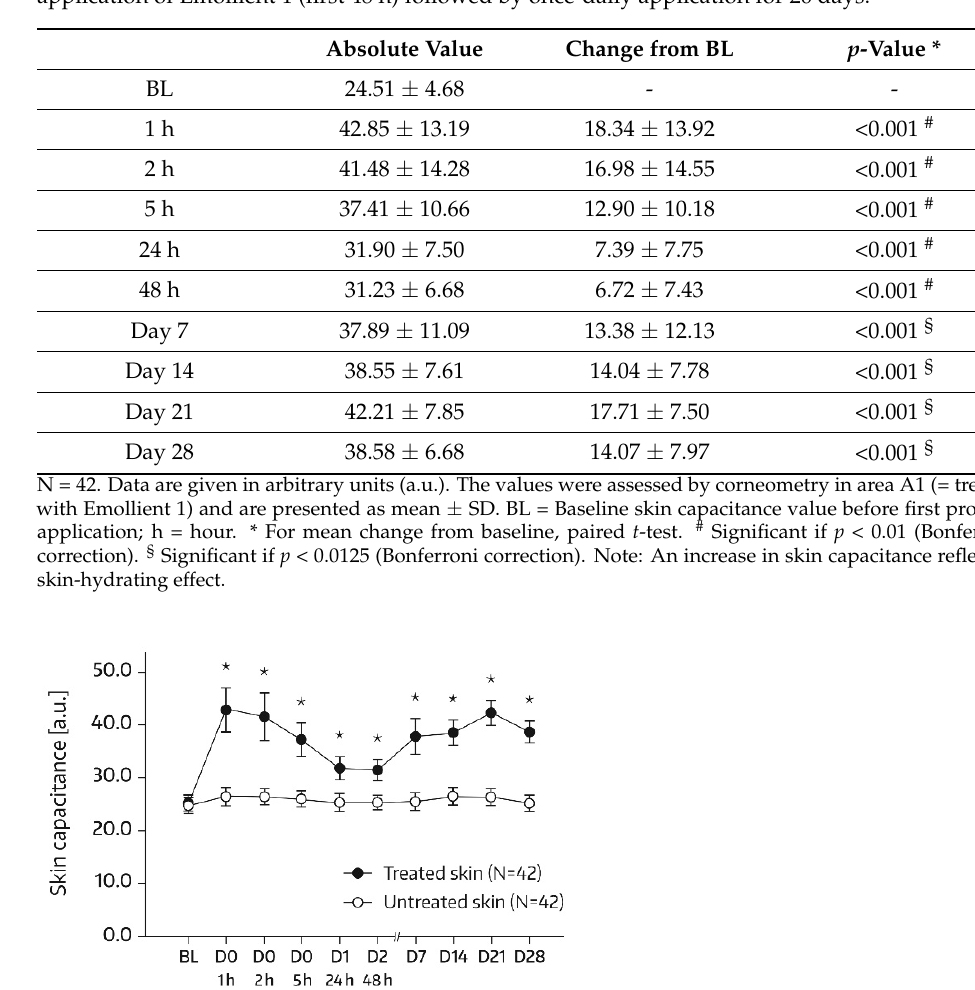
Table 1. Absolute skin capacitance measurement values and changes from baseline after single application of Emollient 1 (first 48 h) followed by once-daily application for 26 days.